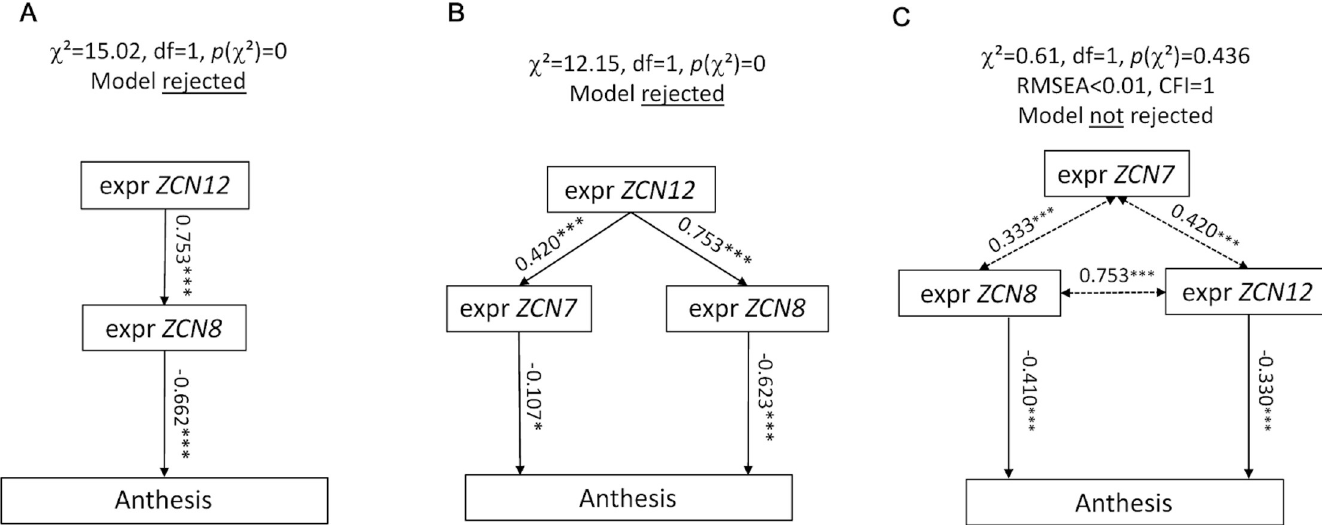
Fig 3. ZCN12 directly affects anthesis. Three families of path diagrams were tested against the whole dataset (BLUEs, platform experiment of 2014). Models in which ZCN12 has an indirect effect on anthesis (A and B) were rejected, whereas models in which both ZCN8 and ZCN12 directly affect anthesis were accepted, with an indirect effect of ZCN7 (C). Arrows, linear functional relationships between anthesis and florigen expression. Simple-headed arrows, relationships are considered as causal by the model. Double-headed arrows, free correlations. Standardized path coefficients are indicated on each arrow with the level of significance ( ��� : P < 0.001, ns: not significant). Other models tested are displayed in S7 Fig.